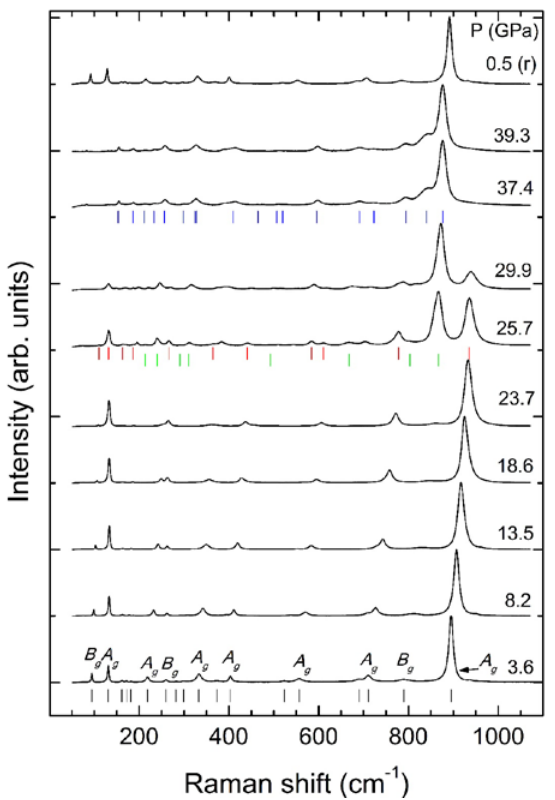
Figure 6. Raman spectra of MnWO 4 at selected pressures. Raman modes of the wolframite phase are identified by ticks (and labeled) in the lowest trace (3.6 GPa). At 25.7 GPa, the modes of the low- and high-pressure phase are identified by red and green ticks, respectively. At 37.4 GPa, the ticks identify the 18 Raman-active modes of the HP phase. Pressures (in GPa) are indicated in each Raman spectrum. The spectrum labeled as 0.5(r) was collected at 0.5 GPa after decompression.